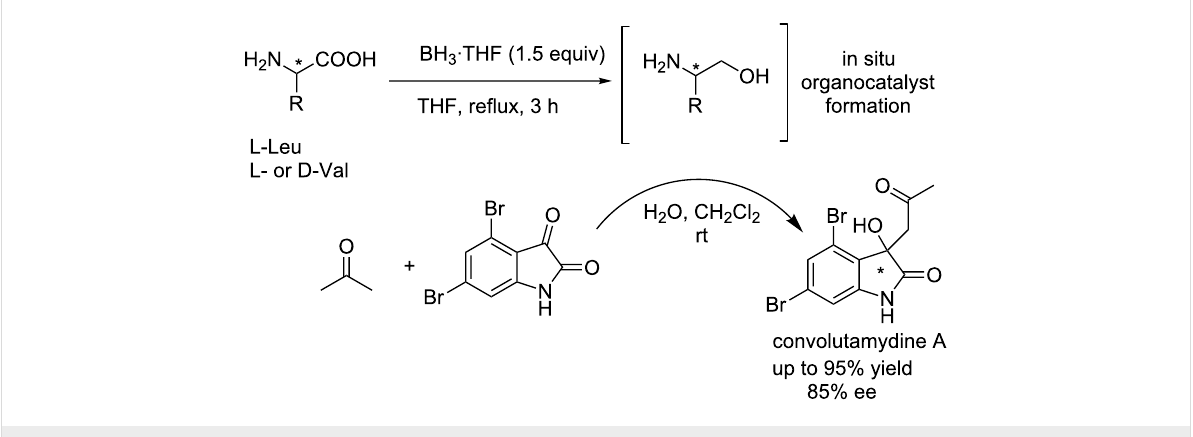
Scheme 23: One-pot asymmetric synthesis of convolutamydine A.